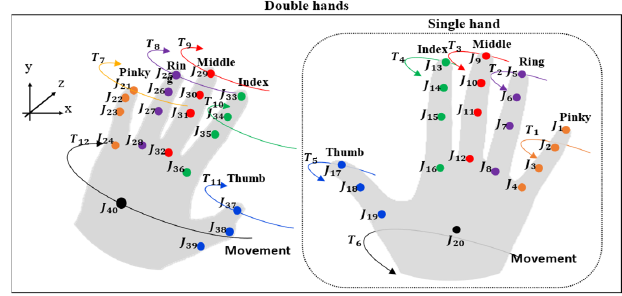
Figure 11. 3D hand motion trajectory patterns for single and double hands.